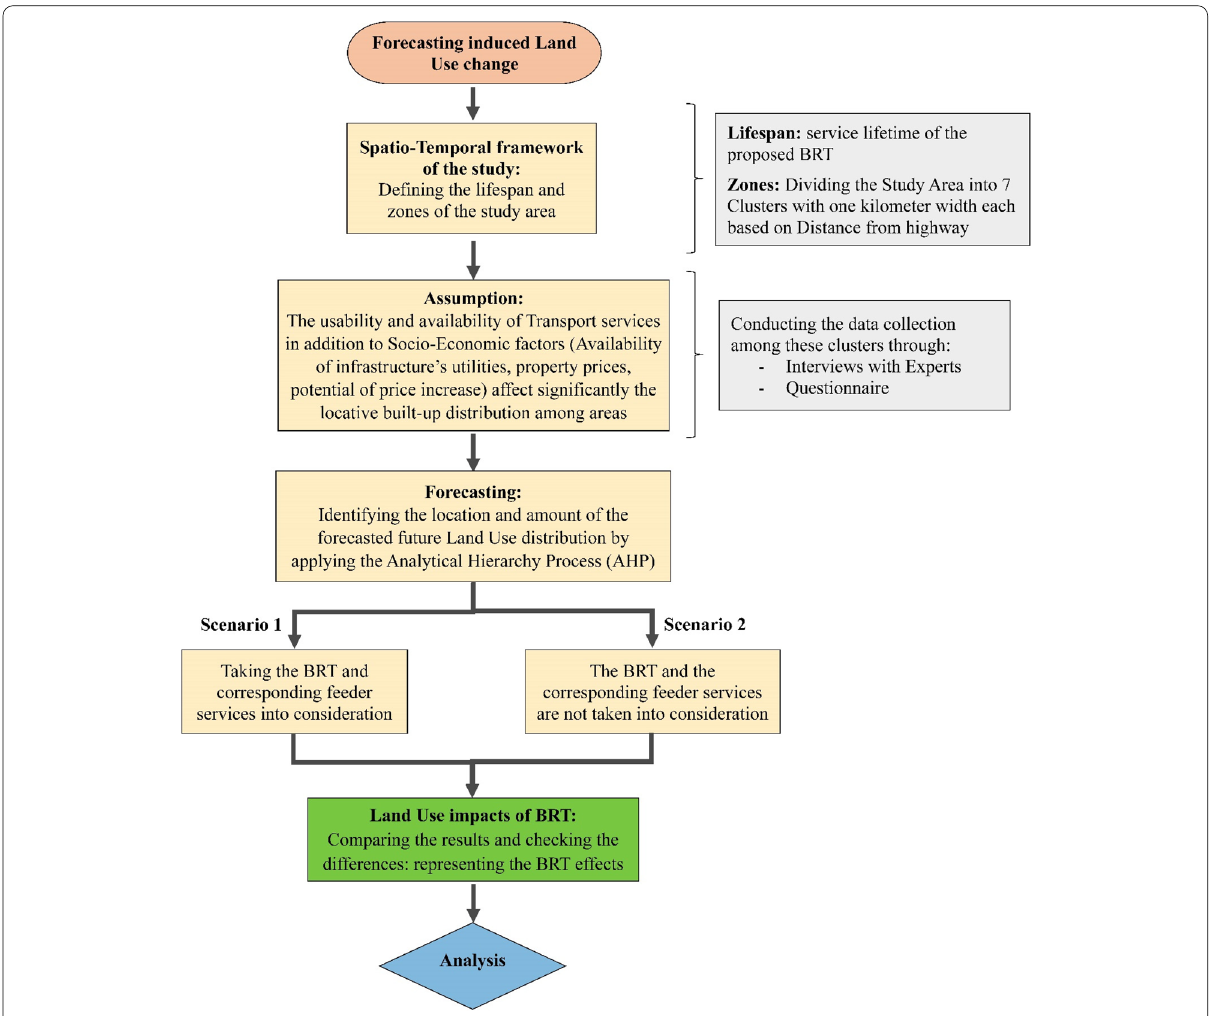
Fig. 6 Analysis process of the urban land use effects of